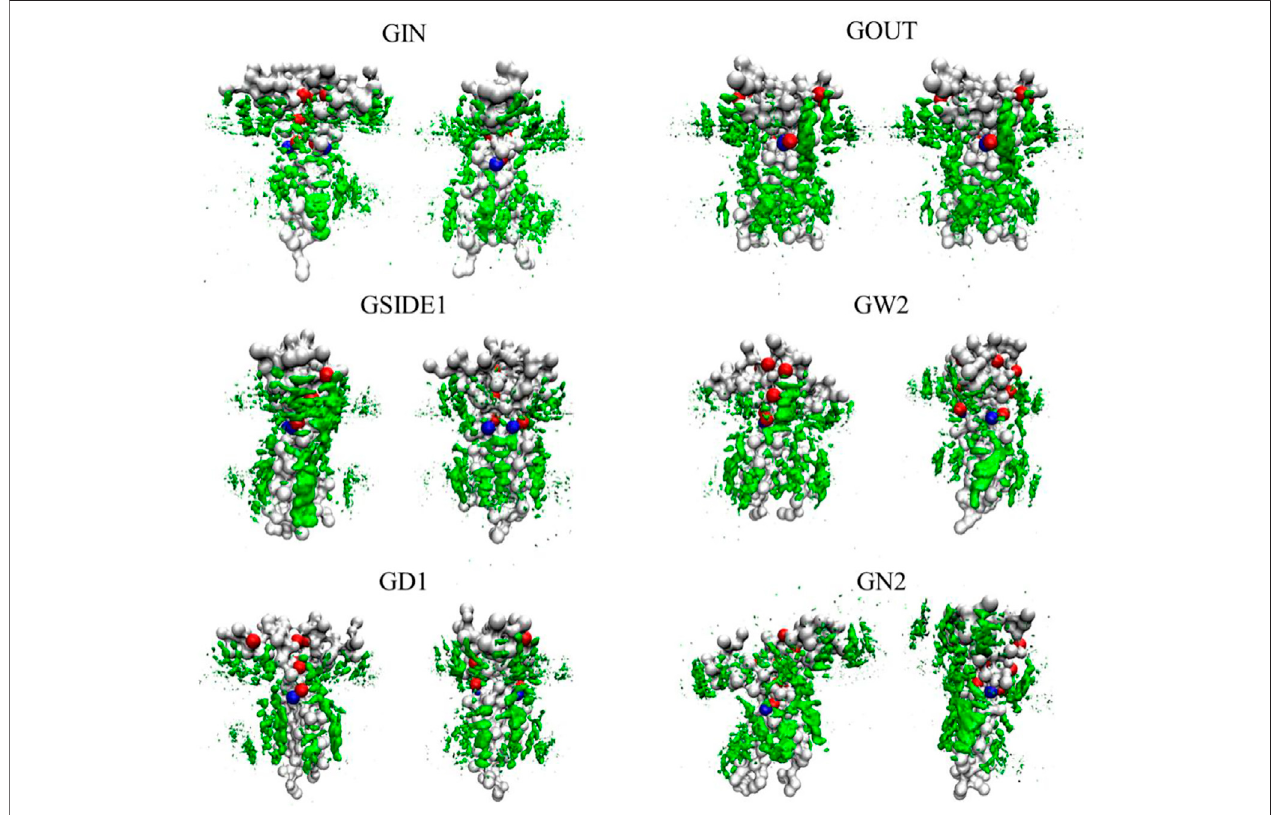
FIGURE2| CholesterolisosurfacesbasedontherestrainsimulationsoftherepresentativeC99dimericconformations,whichwerederivedfromourpreviousstudy (Li et al., 2019). Gly residues are shown in red beads; Ala residues are shown in blue beads; cholesterol isosurfaces are shown on green surface.